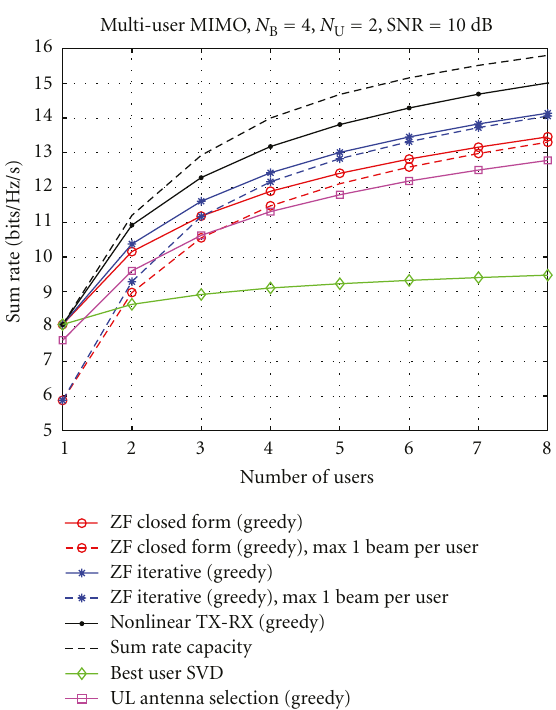
Figure 5: Average sum rate versus number of terminal antennas, with ideal CSI, N B = 4, N U = 2, D S =